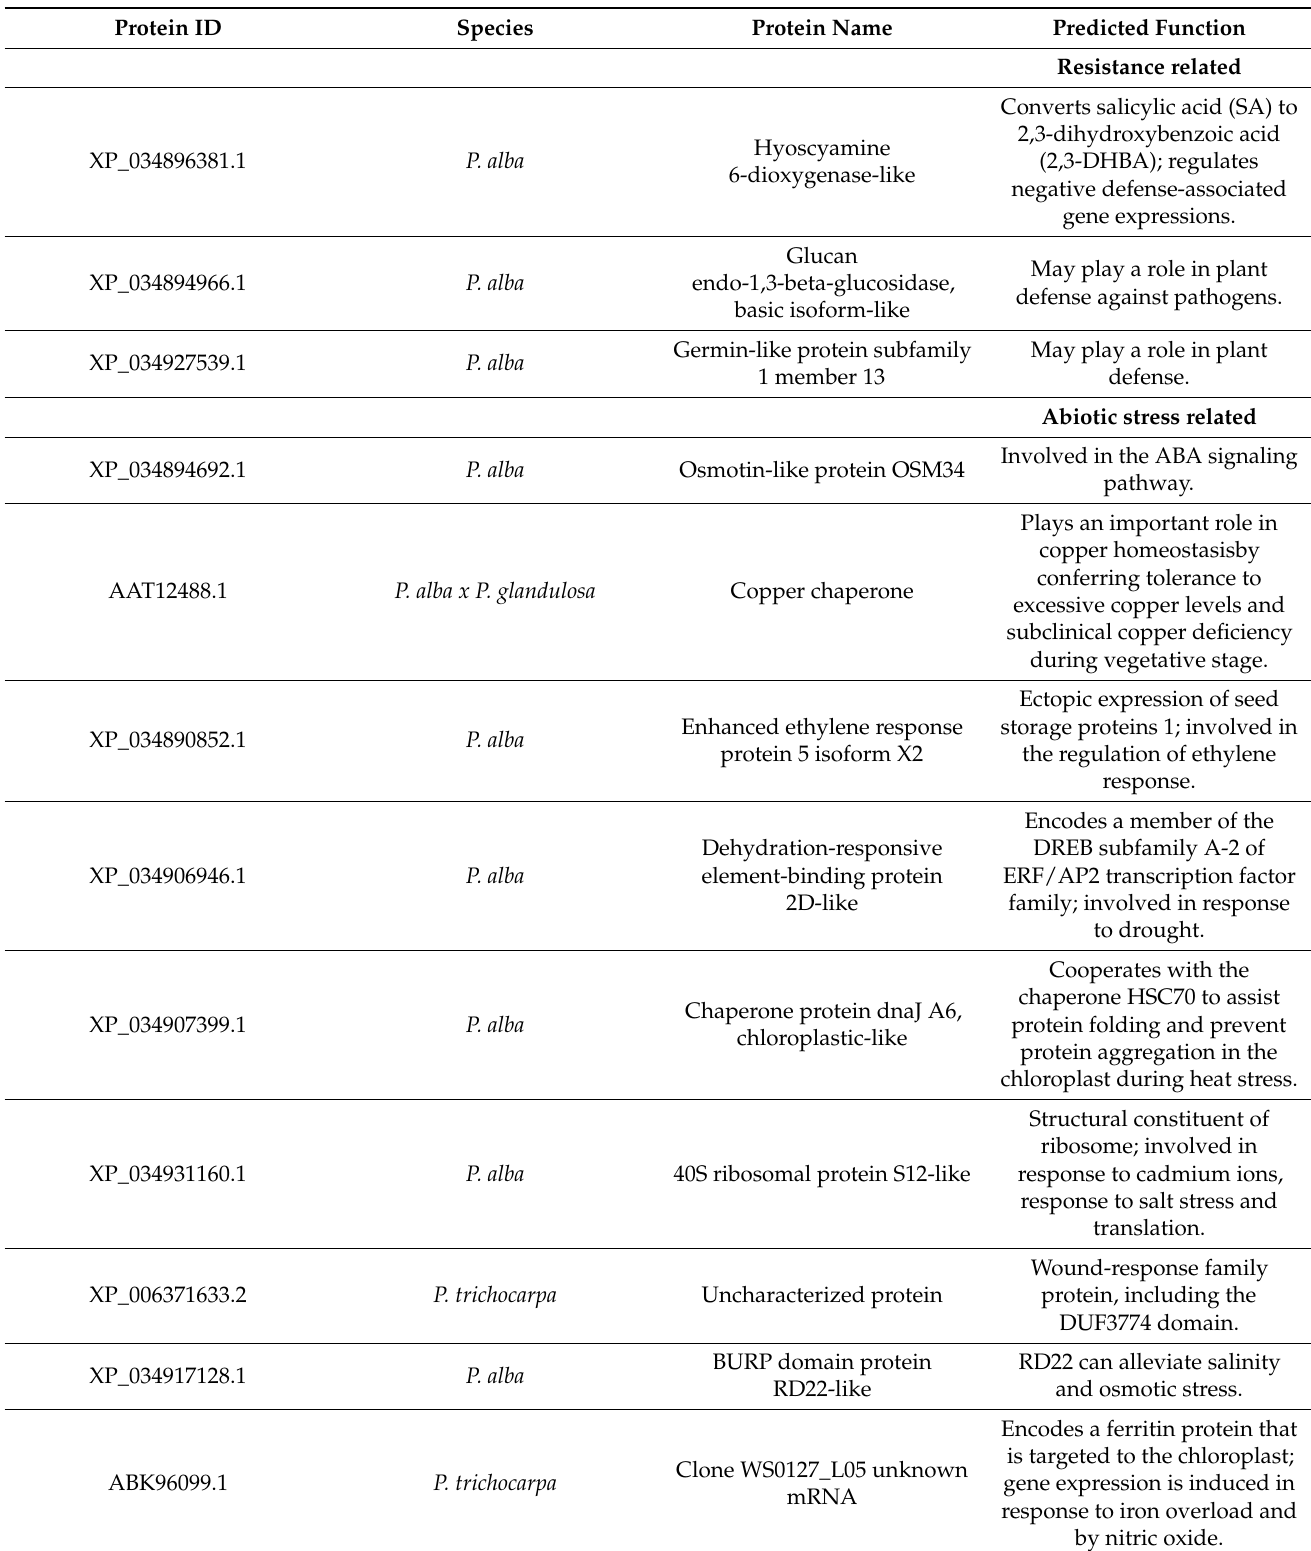
Table 1. The functions of 47 proteins were predicted using the NCBI and STRING